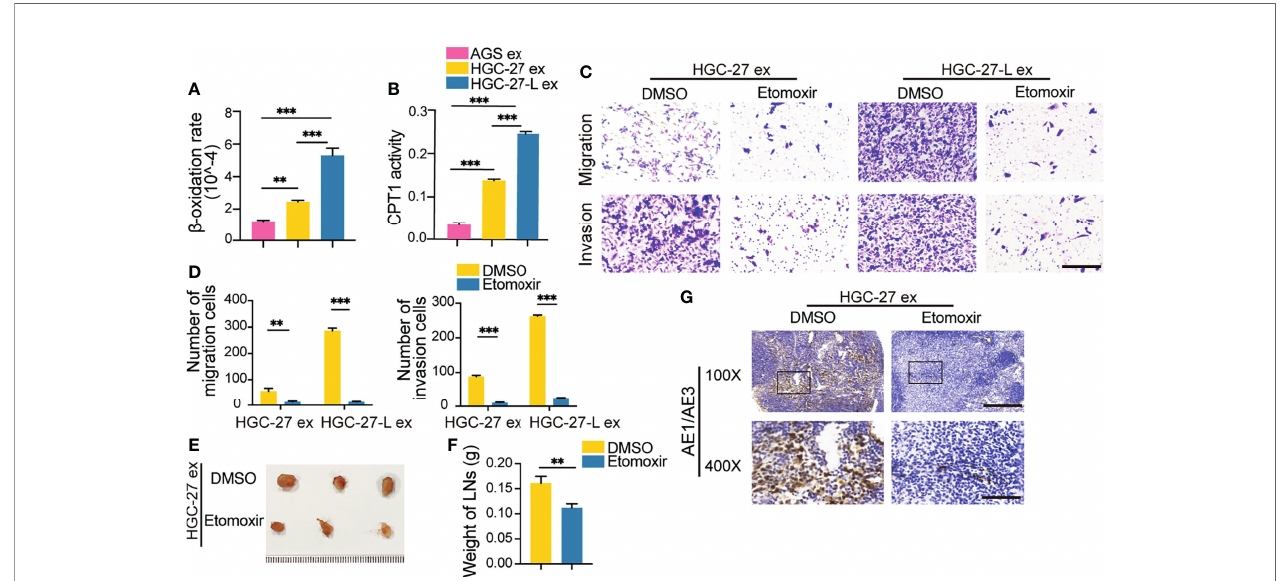
FIGURE 3 | Lymphatic metastatic GC cell-exosomes conferred LNM capacity on primary GC cells depending on FAO (A, B) FAO detection in AGS after treatment with different GC cell exosomes. (A) b -oxidation rate measurement; (B) CPT1 activity analysis; (C – G) Effect of etomoxir pretreatment on lymphatic metastatic GC cell-exosome increasing AGS LNM capacity. (C, D) In vitro migration and invasion assay. (C) Representative images of migrated and invaded cells (magni fi cation, 200×; scale bars, 100 m m); (D) Number of migrated and invaded cells; (E – G) In vivo LNM capacity detection. (E) Images of popliteal LNs. Ruler unit, mm; (F) Weight of LNs; (G) Pancytokeratin AE1/AE3 staining in LNs (magni fi cation, 100×; scale bars, 200 m m; magni fi cation, 400×; scale bars, 50 m m); ex, exosomes. ** P < 0.01; *** P <